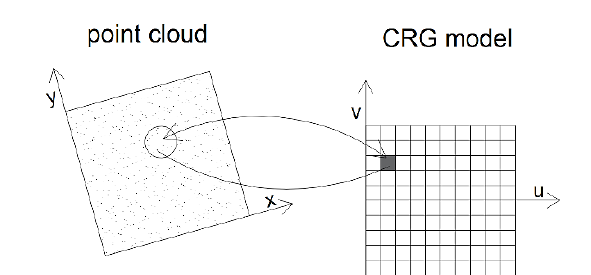
Figure 4. The projection of the CRG cell into the point cloud’s global coordinate system with the neighborhood represented by the circle and the transfer of the mean height information back into the CRG cell